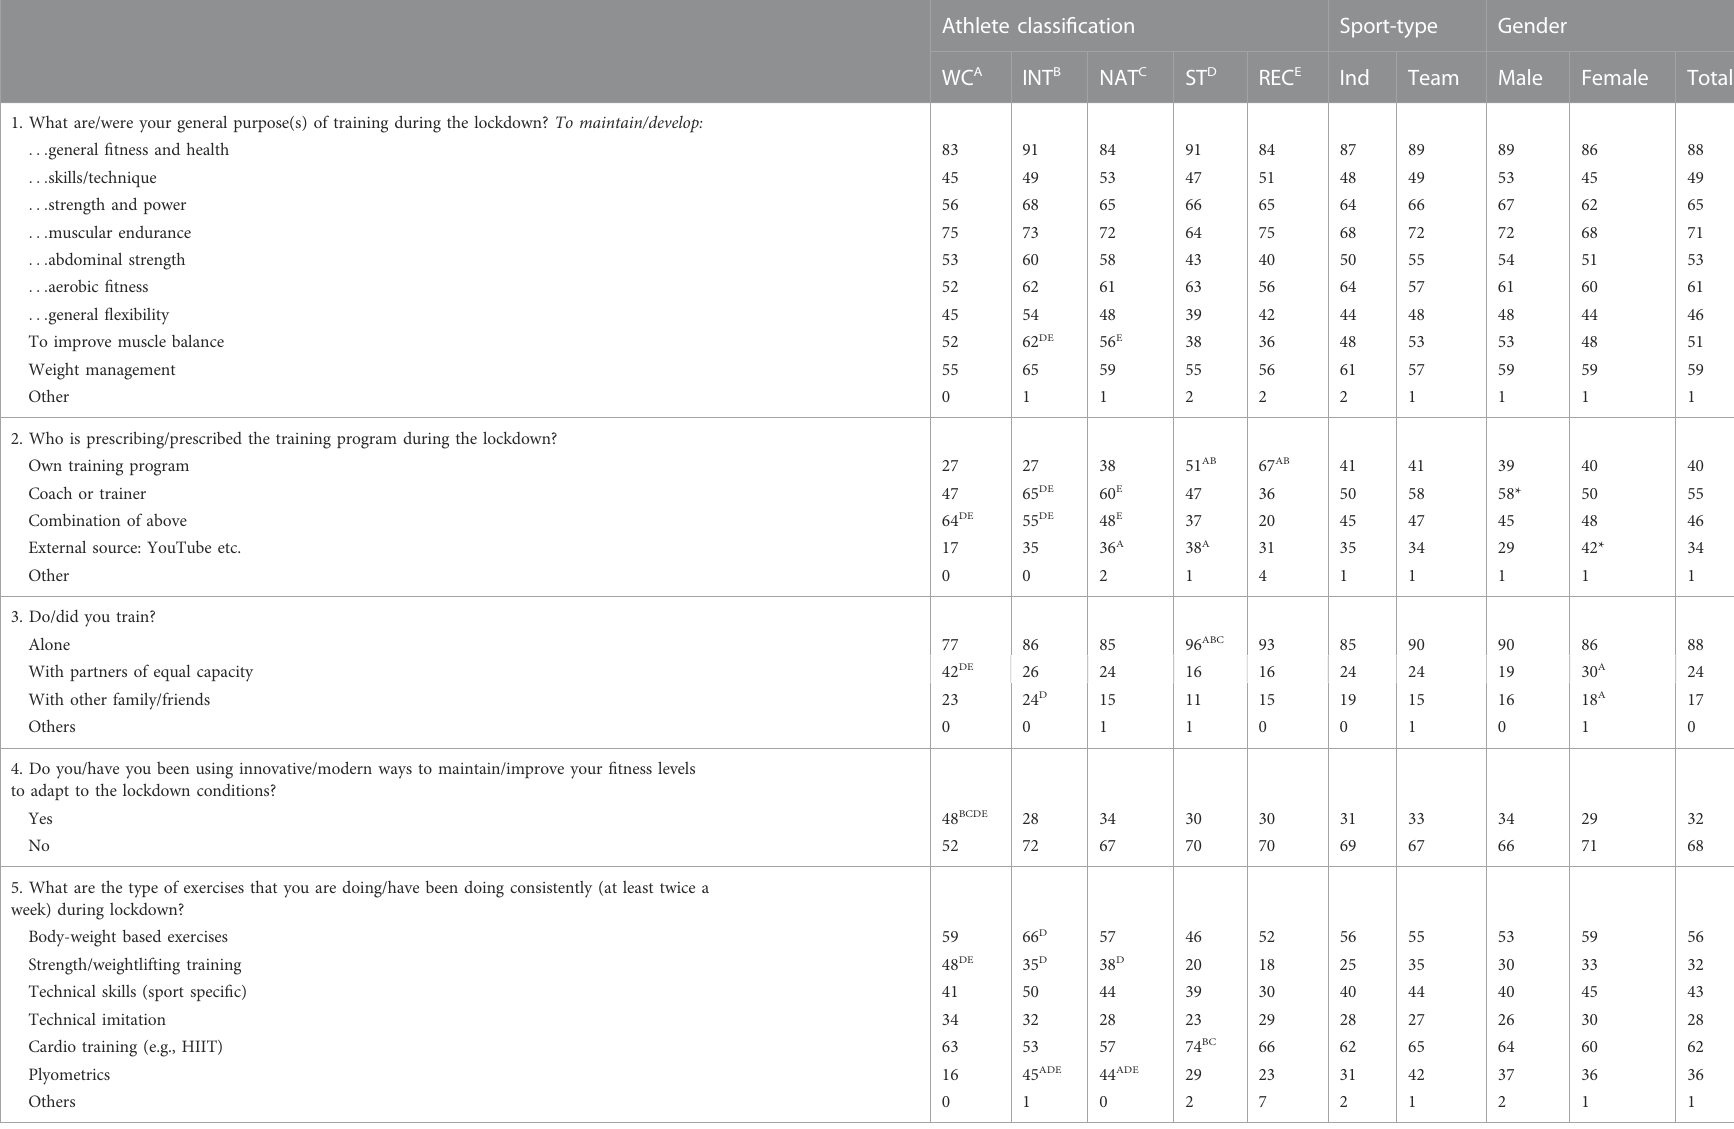
TABLE 2 Training practices during COVID-19 lockdown in Malaysia by athlete classi fi cation, sport-type, gender, and total cohort (percentage of